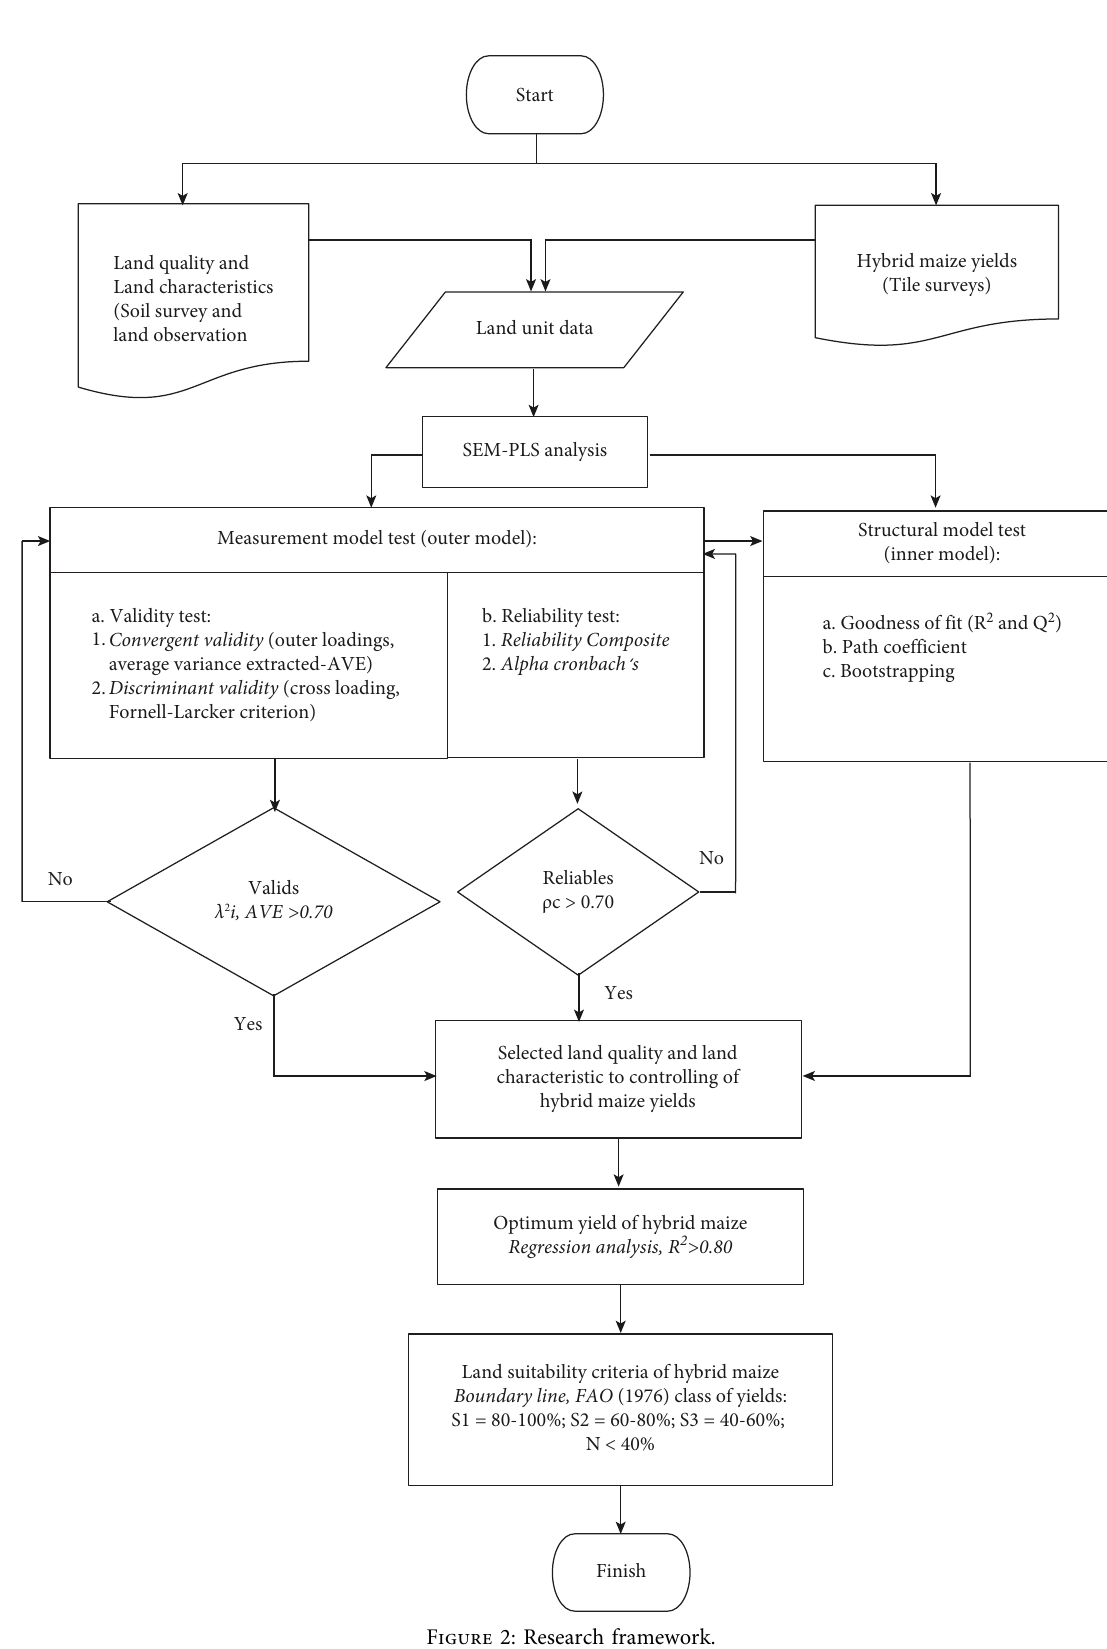
Figure 2: Research